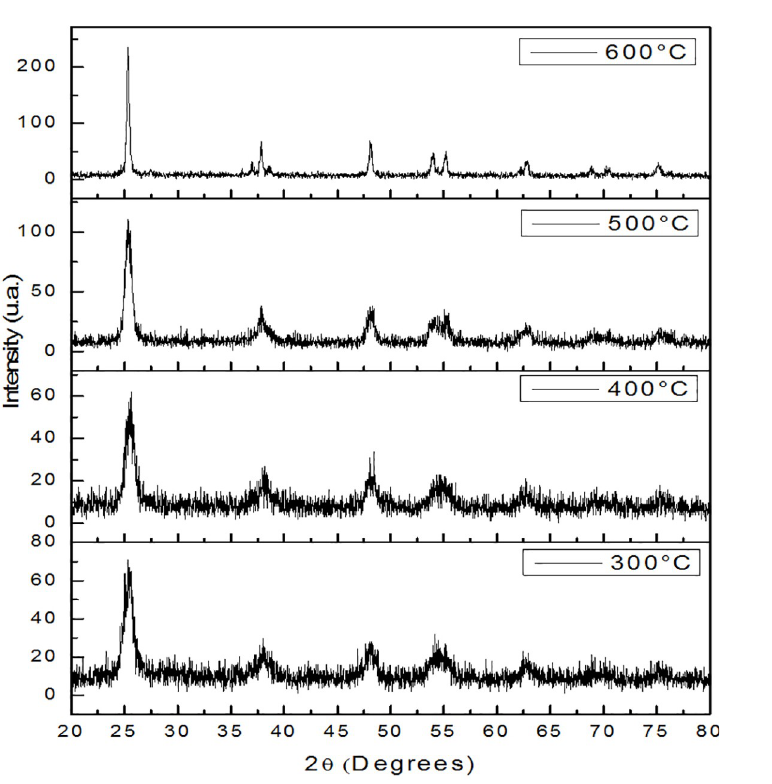
Fig 3. Diffractograms from samples of Ag-TiO 2 . That samples were sintered at 300, 400, 500 and 600˚C.